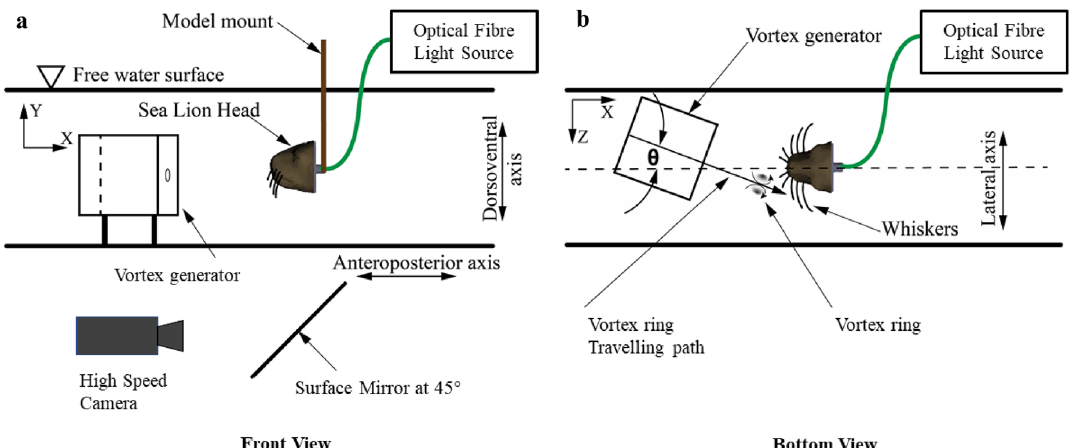
Figure 3. Schematic diagram of the seal head experimental set-up. To test different contralateral angles of impact, the vortex cannon is rotated around the head in between measurements. θ = 0